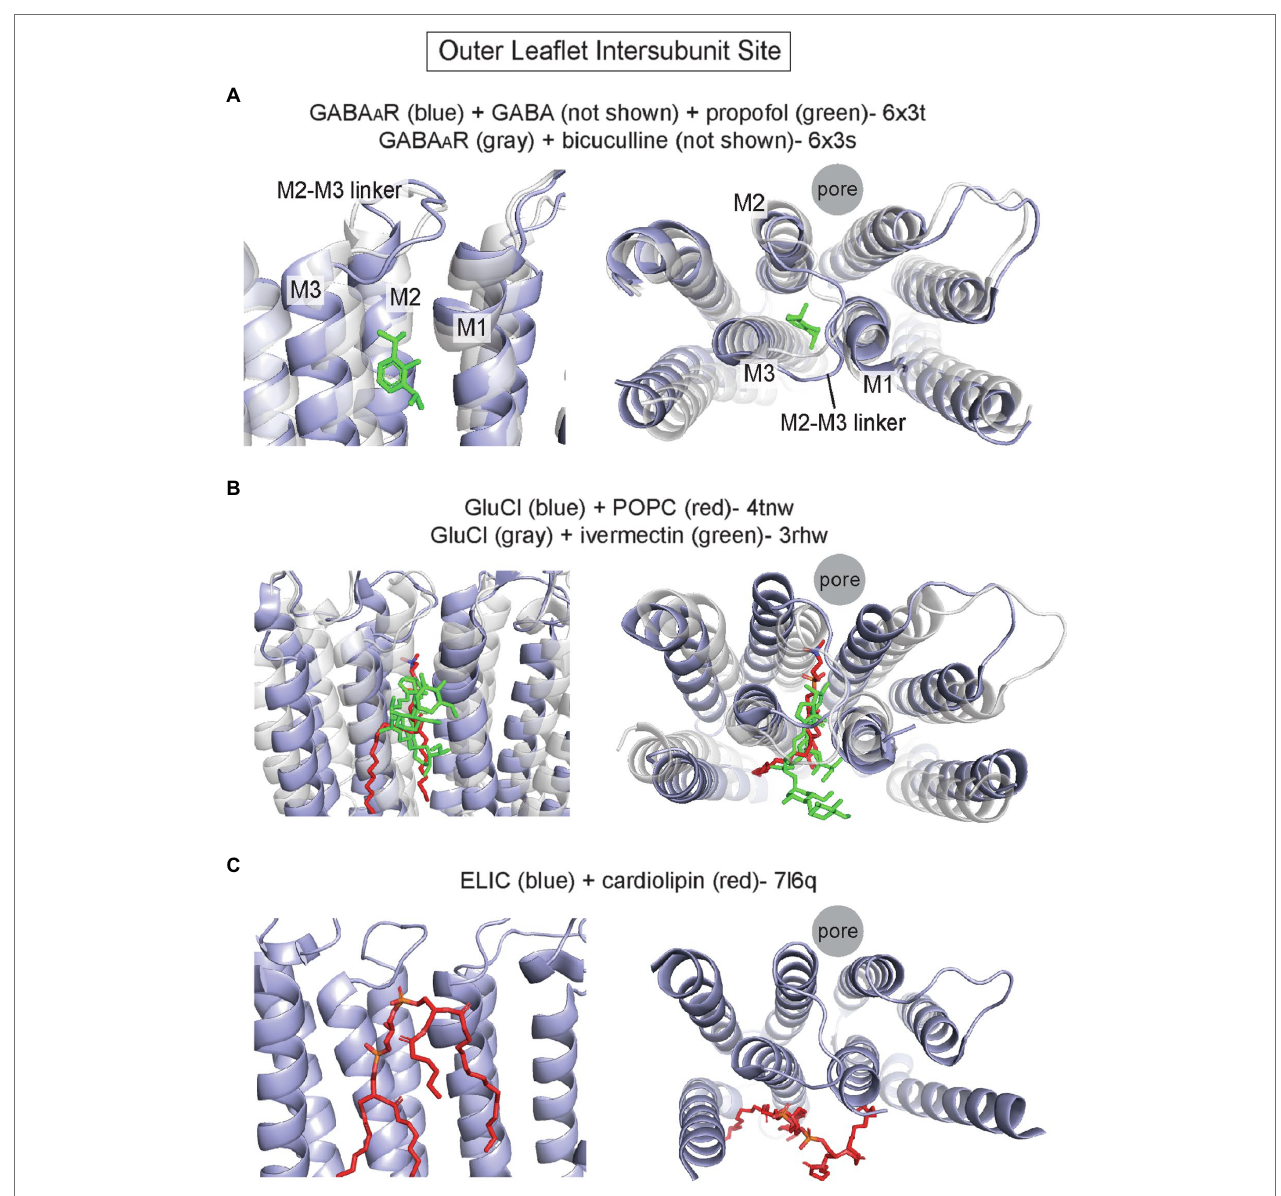
FIGURE 2 | Outer leaflet intersubunit binding site in pLGICs. (A) α 1/ β 2 interface of α 1/ β 2/ γ 2 GABA A R with GABA and propofol (pdb 6x3t), and the α 1/ β 2 interface of α 1/ β 2/ γ 2 GABA A R with the competitive antagonist, bicuculline (pdb 6x3s). The activated conformation in the GABA + propofol structure is associated with an outward movement (away from the pore axis) of the top of M2, M3 and the M2-M3 linker. (B) GluCl with POPC (pdb 4tnw) and GluCl with ivermectin (pdb 3rhw). Binding of ivermectin to the intersubunit site opens the channel pore and is associated with similar conformational changes as noted above in the GABA A R. (C) Apo ELIC with cardiolipin (pdb 7l6q). The cardiolipin occupies a surface at the intersubunit